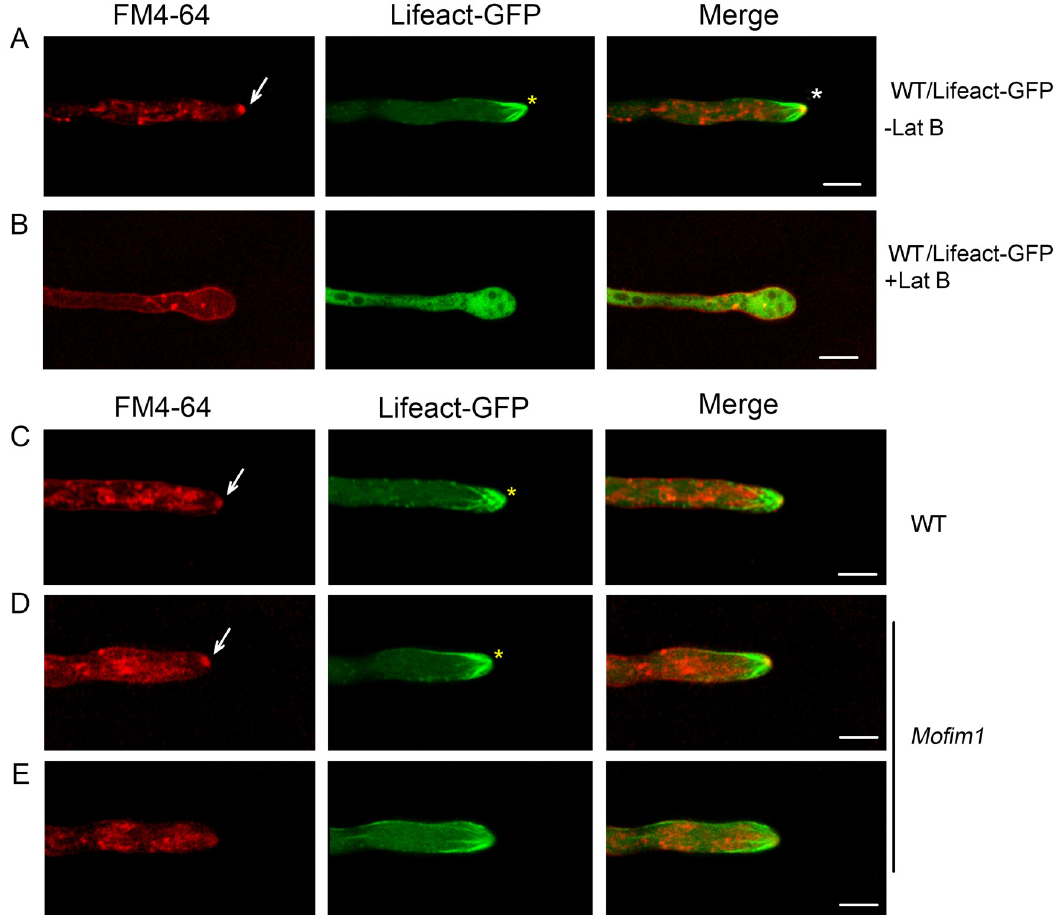
Fig 7. Defects in actin cytoskeleton-mediated endocytosis in Mofim1 . (A) Colocalization of the actin cytoskeleton and FM4- 64-labeled Spk. The arrowhead indicates FM4-64-labeled Spk. The asterisk indicates the fluorescence merge of FM4-64 and actin at the Spk. Bar = 5 μ m. (B) Colocalization of Lifeact-GFP and FM4-64 in hyphae pretreated with Lat B for 30 min. Bar = 5 μ m. (C–E) Representative images showing FM4-64 stained hyphae of WT (C) or the Mofim1 mutant with (D) or without a Spk (E) . The arrowheads indicate FM4-64-labeled Spk and the yellow asterisks indicate actin at the Spk. Bars = 5 μ m.